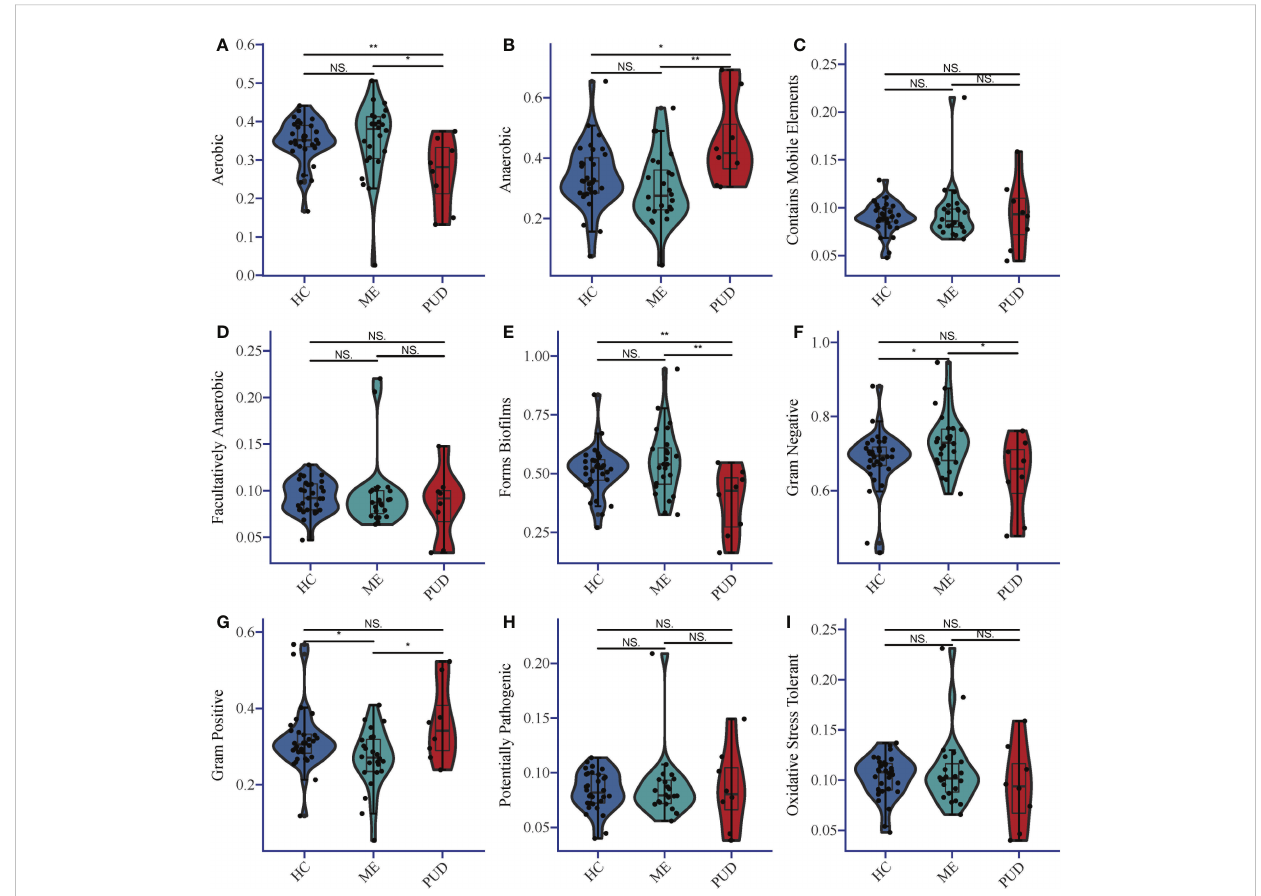
FIGURE 3 Phenotypic differences in colonies based on Bugbase prediction. (A) , Aerobic; (B) , Anaerobic; (C) , Contains Mobile Elements; (D) , Facultatively Anaerobic; (E) , Forms Bio fi lms; (F) , Gram Negative; (G) , Gram Positive; (H) , Potentially Pathogenic; (I) , Oxidative Stress Tolerant. The horizontal line in the violin plot is the mean and the error bars are the standard deviation. *, a signi fi cant difference between the two groups (P<0.05); **, a highly signi fi cant difference between the two groups (P<0.01); NS, no signi fi cant difference between the two groups (same